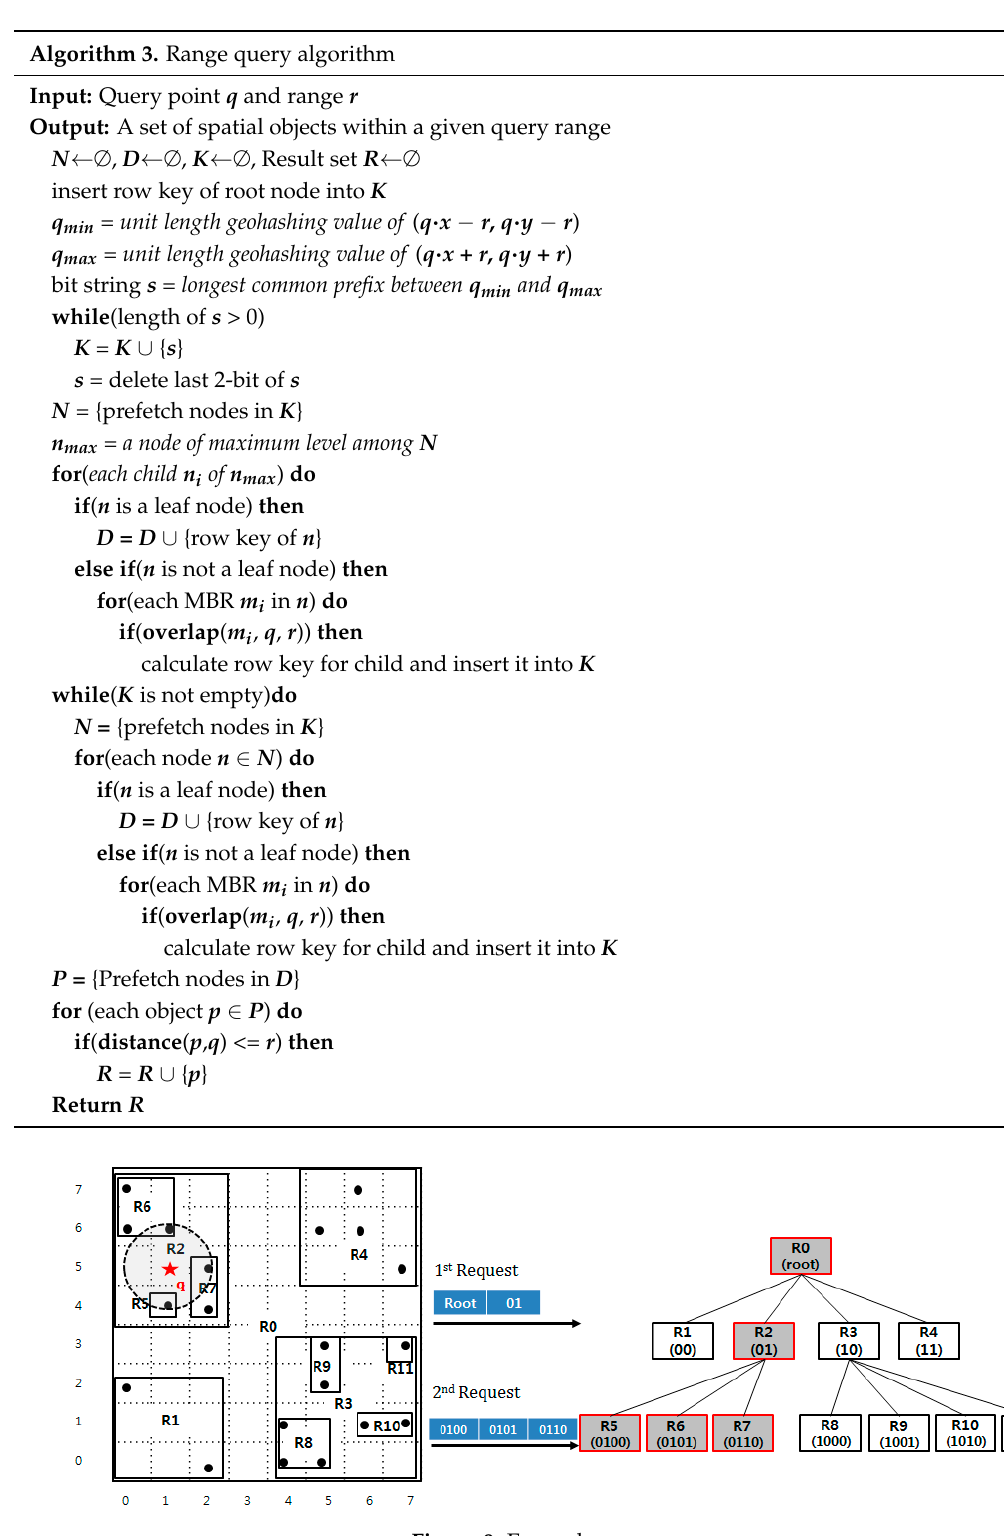
Figure 9. Example range query.